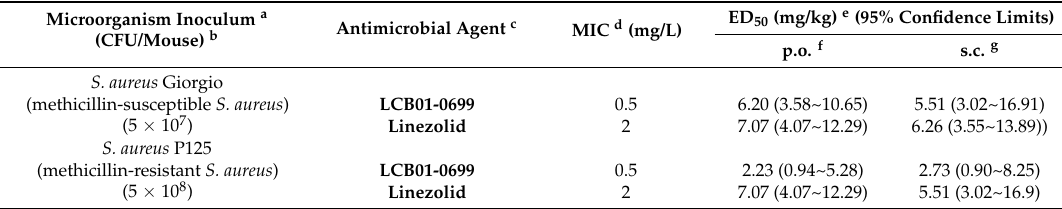
Table 2. In vivo activity of LCB01-0699 against S. aureus in a mouse model of systemic infection. Microorganism Inoculum a Antimicrobial Agent (CFU/Mouse) b